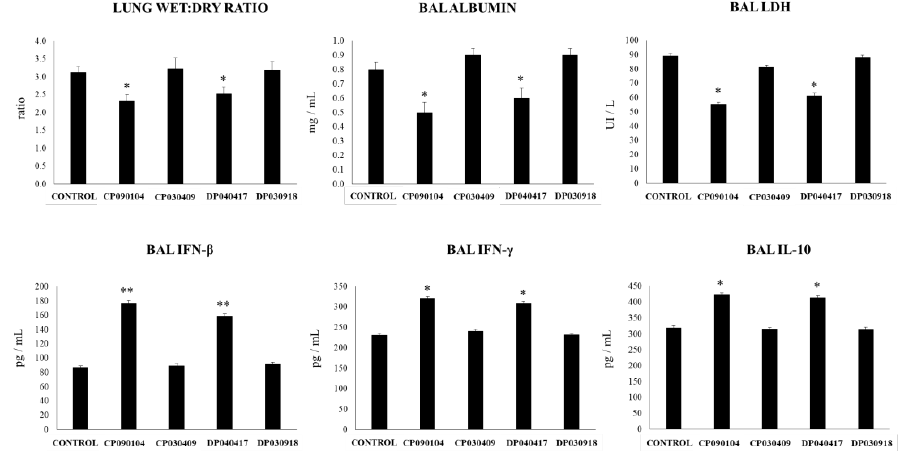
Figure 2. Effect of respiratory commensal bacteria strains on lung tissue damage and respiratory cytokines induced by the nasal administration of a mixture of the MALP2 and Pam3CSK4 ligands that signal through TLR2/TLR6 and TLR2/TLR1, respectively. Infant mice were nasally primed with viable Corynebacterium pseudodiphteriticum (CP) strains 090104 or 030409 or Dolosigranulum pigrum (DP) strains 040417 or 030918 during five consecutive days and then challenged with two once-daily doses of MALP2/Pam3CSK4. Non-treated infant mice challenged with MALP2/Pam3CSK4 were used as controls. Two days after the last MALP2/Pam3CSK4 administration lung wet:dry weight ratio, lactate dehydrogenase (LDH) activity and, albumin concentrations and the levels of interferon (IFN)- β, IFN - γ, and interleukin (IL)-10 in broncho-alveolar lavages (BAL) were determined. Experiments were performed with 5 – 6 mice per group. The results represent data from three independent experiments. Significantly different when compared to control * p < 0.05 or ** p < 0.01.